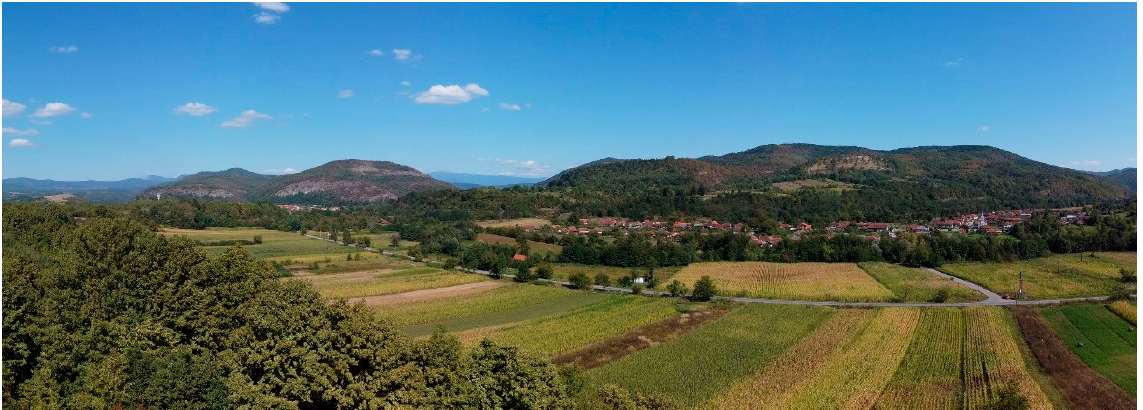
Figure 3. N–S photo panorama taken with a drone from the western side of the Bont ă u volcano (to the right) inside the Z ă rand basin viewing toward the left two Dome structures. The closest one to the volcano is named here as Gurahon ţ , after the closest town.